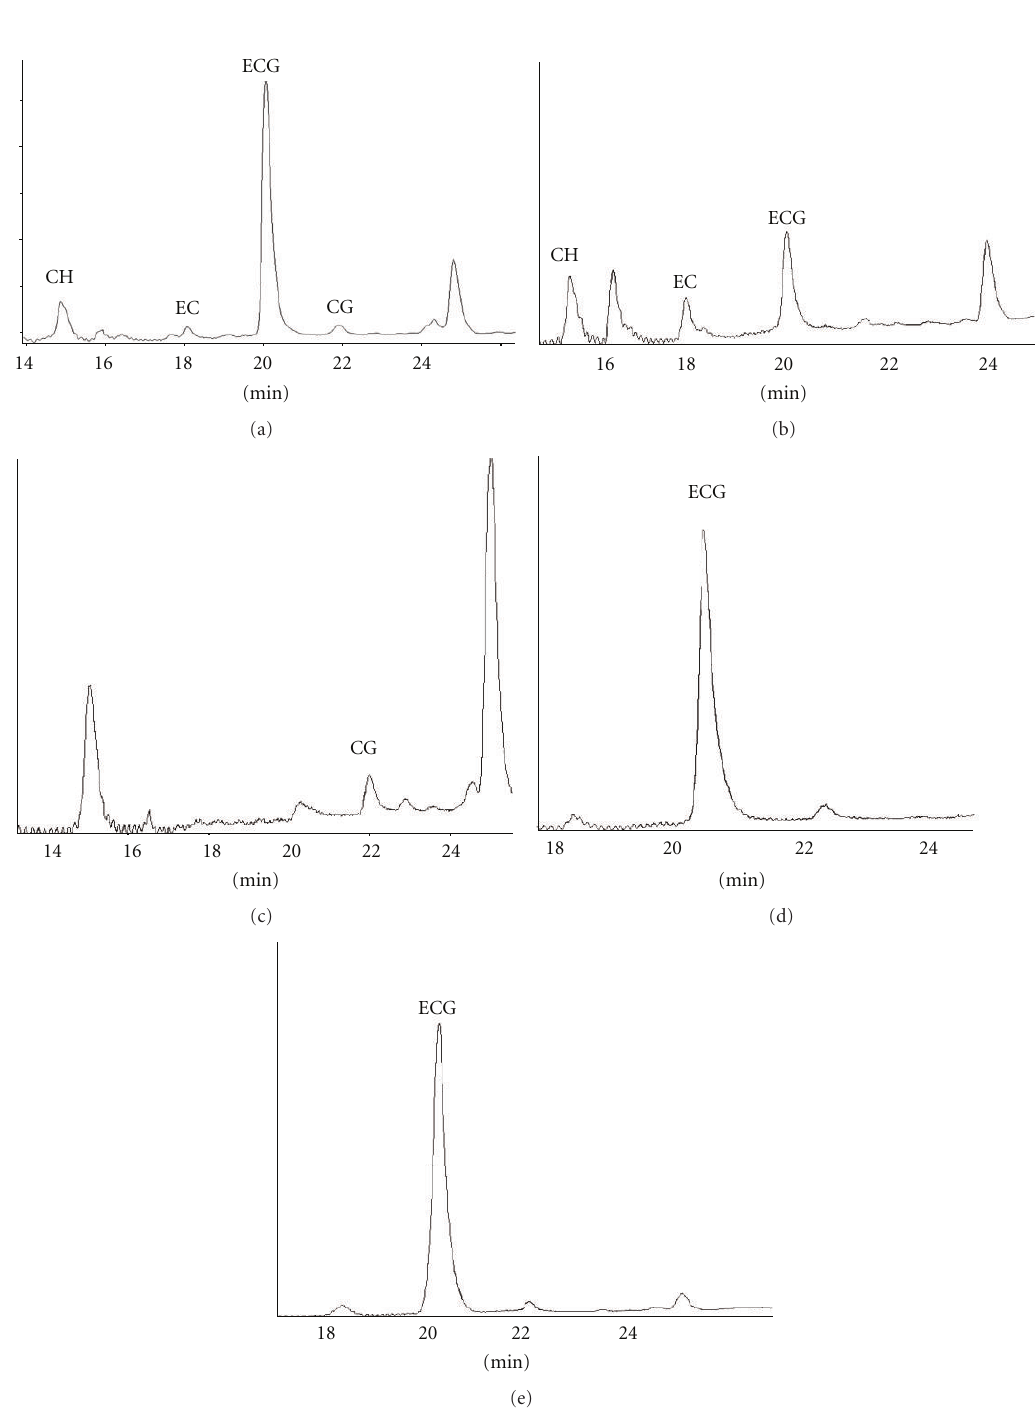
Figure 4: (a) Chromatogram of ( ± )-catechin hydrate (0.13 mg/L), ( − )-epicatechin (0.01 mg/L), ( − )-epicatechin gallate (0.36 mg/L), and ( − )-catechin gallate (0.04mg/L) in M9 medium supplemented with 1mM IPTG and 40 g/L glucose and 3mM eriodictyol; (b) chromatogram of ( ± )-catechin hydrate (0.04mg/L), ( − )-epicatechin (0.02mg/L), ( − )-epicatechin gallate (0.04 mg/L) in M9 medium supplemented with 1mM IPTG and 10g/L glucose and 3mM eriodictyol; (c) chromatogram of ( − )-catechin gallate (0.05mg/L) and unknown compounds in cultures without IPTG; (d) chromatogram of biosynthesized ( − )-epicatechin gallate, (0.08 mg/L) in M9 medium supplemented with 0.5 mM IPTG and 1 mM eriodictyol; (e) chromatogram of ( − )-epicatechin gallate (0.34 mg/L) production at 1 mM IPTG and 3 mM eriodictyol in M9